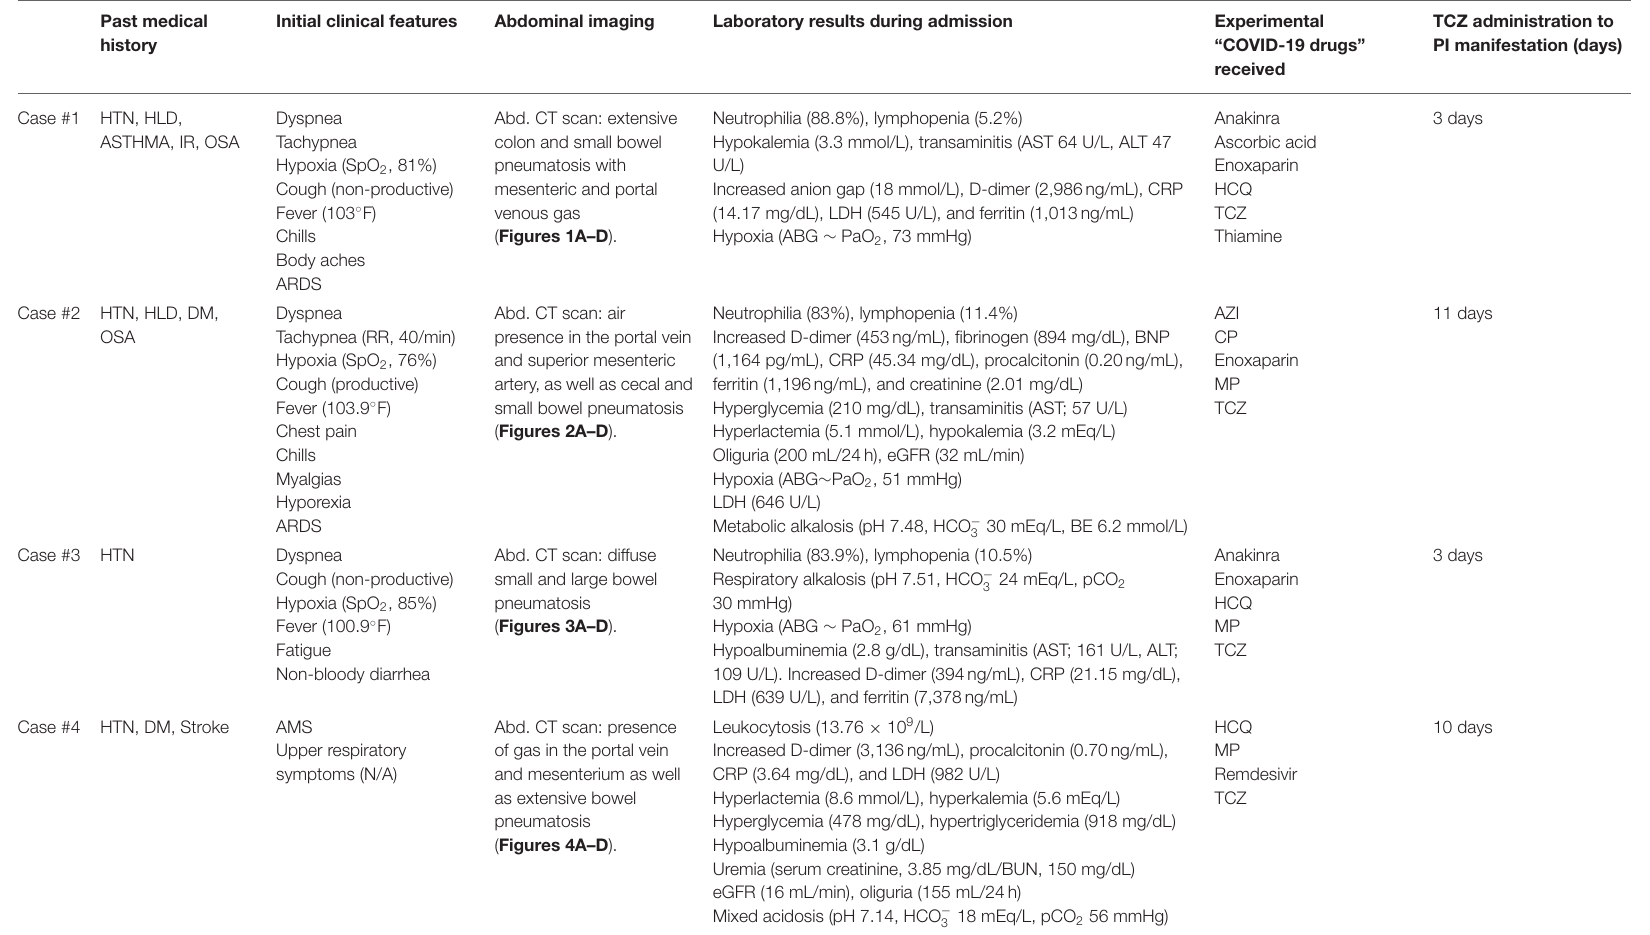
TABLE 1 | Pneumatosis intestinalis in the setting of COVID-19: case series summary. Past medical